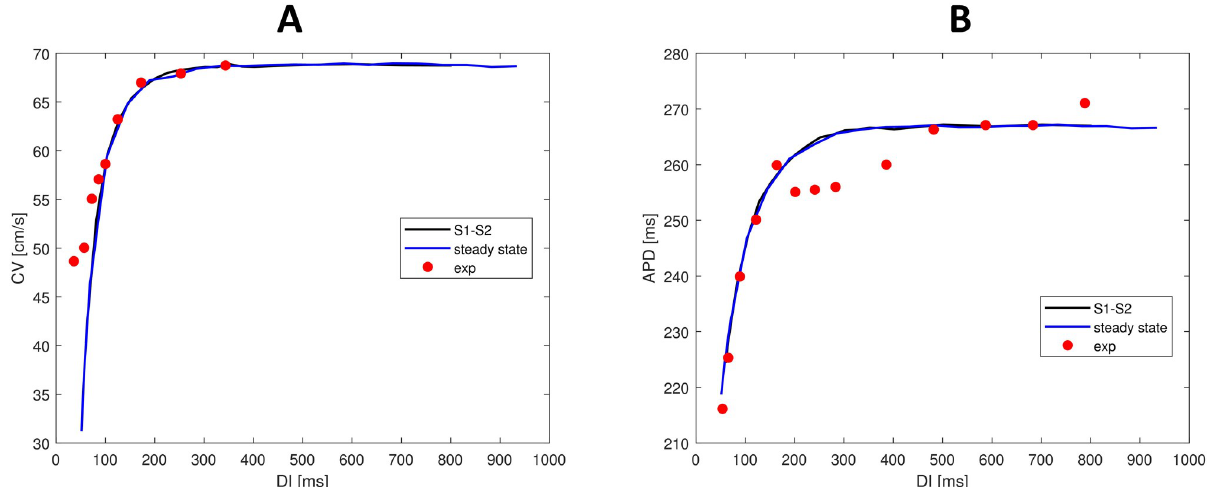
Fig 4. APD and CV restituition curves in tissue for the proposed model. (A) S1-S2 and steady-state APD restitution curves reproduced by our model. For comparison, experimental data from human tissue measured by Morgan et al. [24] are shown. (B) S1-S2 and steady-state CV restitution curve reproduced by our model. Experimental guinea pig data from Girouard et al. [38] are added for comparison. As in [8, 15], the experimental data are rescaled by a factor of 0.92 to get the same maximum CV level as measured in human tissue [39].